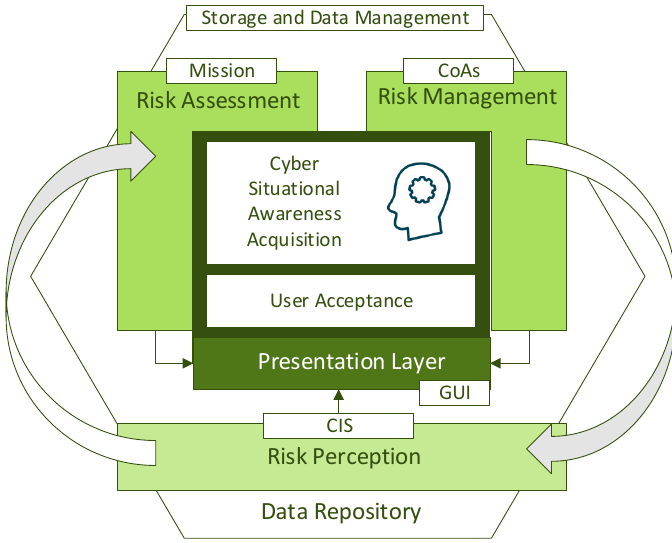
Figure 9. Evaluation Workflow